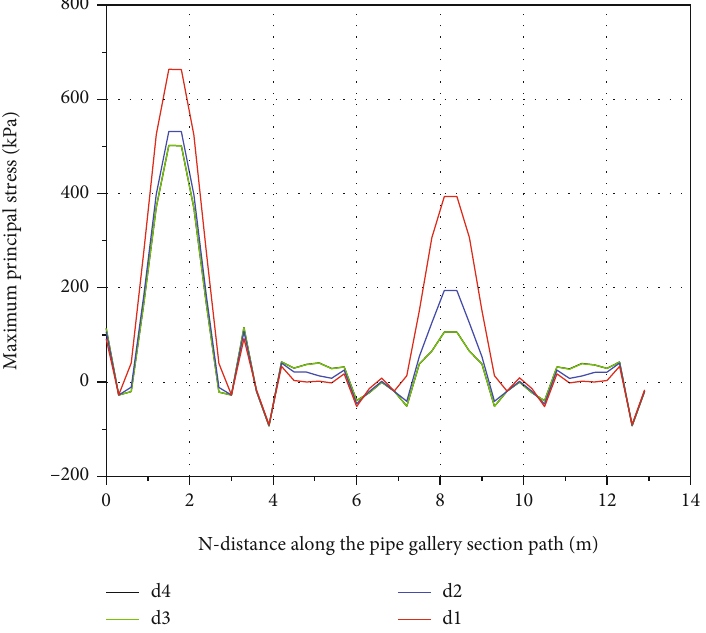
Figure 10: Distribution curve of maximum principal stress on the N side.